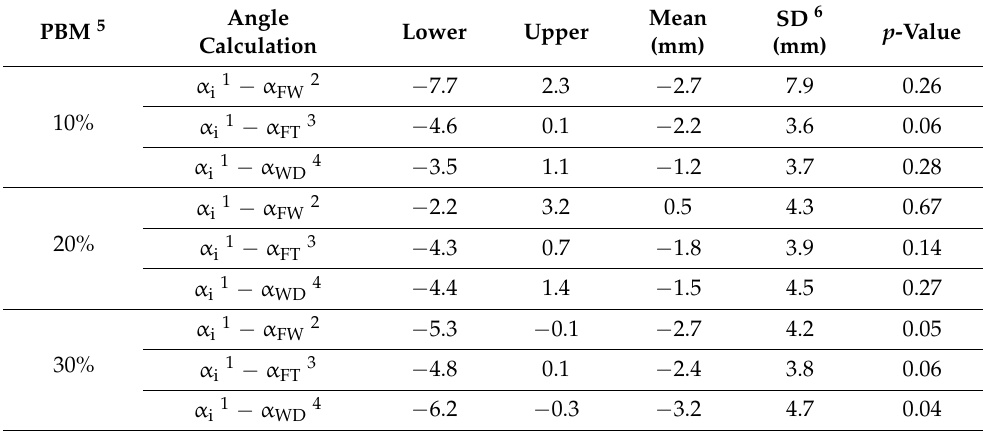
Table 2. Calculated differences in angle α , indicating craniocaudal movement, for each load and surgical treatment.